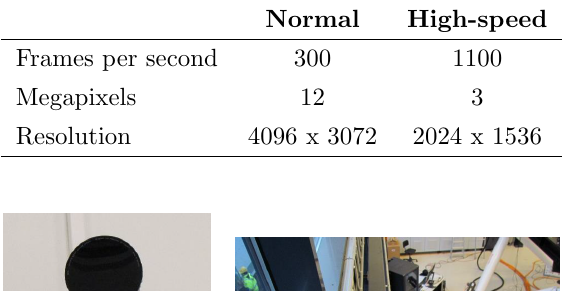
Table 1: Qualisys Qqus 700+ capture-modes